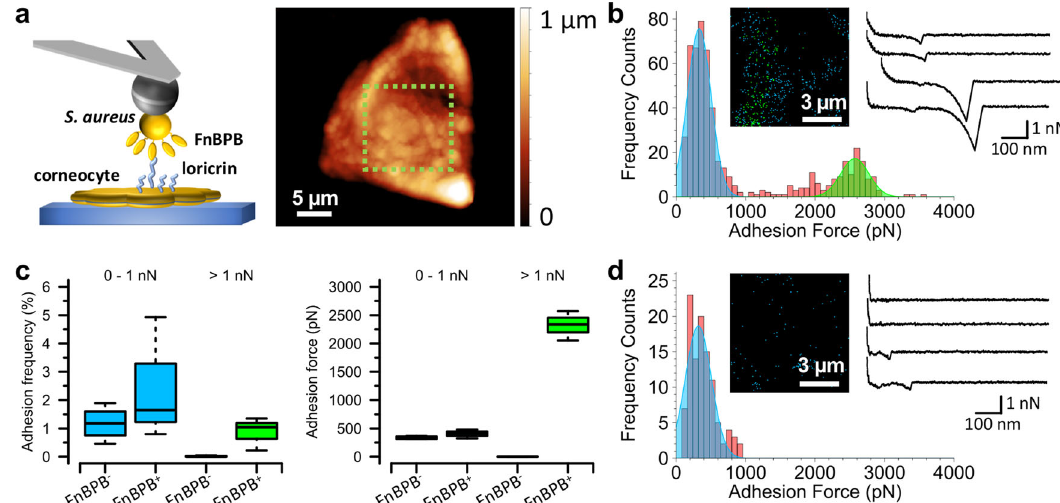
Fig. 7 FnBPB expressed on living S. aureus cells forms ultrastrong single molecular complexes with ligands exposed on corneocyte surfaces. Binding forces between S. aureus and corneocytes. a Single bacterial cells were attached to a dopamine-treated (wet adhesive) colloidal probe and used to force probe corneocytes on tape strips in quantitative imaging (QI) mode. Height image of a single corneocyte produced with an S. aureus probe. The green zone indicates where subsequent QI adhesion data were recorded. b Representative data for S. aureus SH1000 4X (pFnBPB) cells. Left, histograms of binding forces with inset of the corresponding adhesion map. Black pixels show where zero adhesion was measured and blue pixels show where adhesive interactions between 0 and 1000 pN were detected. Green pixels are where adhesive interactions greater than 1000 pN were detected. Right, representative force-extension curves. c Boxplots of adhesion forces and frequencies for S. aureus SH1000 4X (pALC2073) cells [FnBPB − ] and S. aureus SH1000 4X (pFnBPB) cells [FnBPB + ] used to probe corneocytes. Whiskers show the range, the boxes the interquartile range, the thick lines within the boxes the median and open circles outliers. n = 772 adhesive curves from three independent bacterial cells. Adhesion frequency values for FnBPB − and FnBPB + cells were subjected to statistical testing using a two-sided Wilcoxon rank-sum test with continuity correction. For adhesion forces >1 nN, P = 0.0436 and for adhesion forces 0 – 1 nN, P = 0.6286. d Representative data for the control S. aureus SH1000 4X (pALC2073) strain that does not express FnBPB. n = 1209 adhesive curves from three independent bacterial